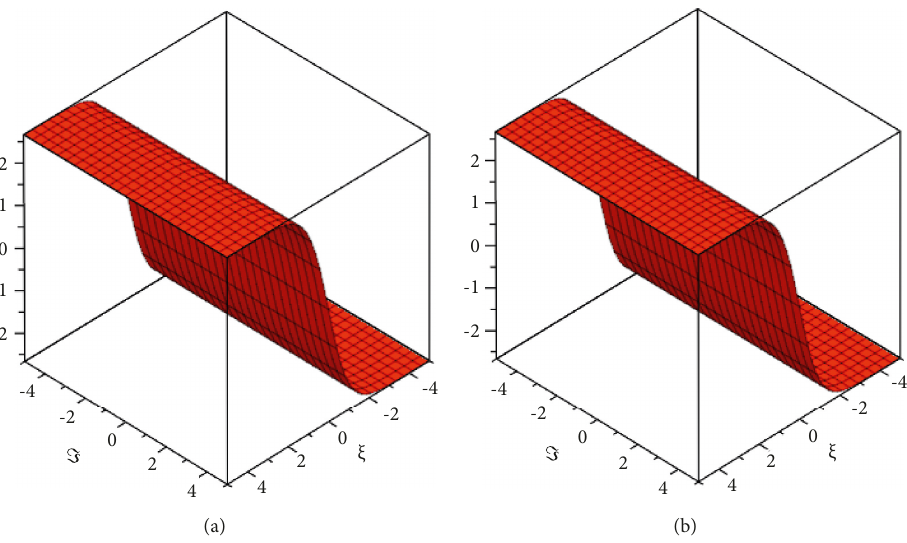
Figure 5: Exact solution and analytical solution for ℓ ( ξ , I ) problem 2. Table 3: Comparison of the proposed method and exact results with absolute error (AE) at various fractional order for φ ( ξ , I ) of problem 2. I � 0 .